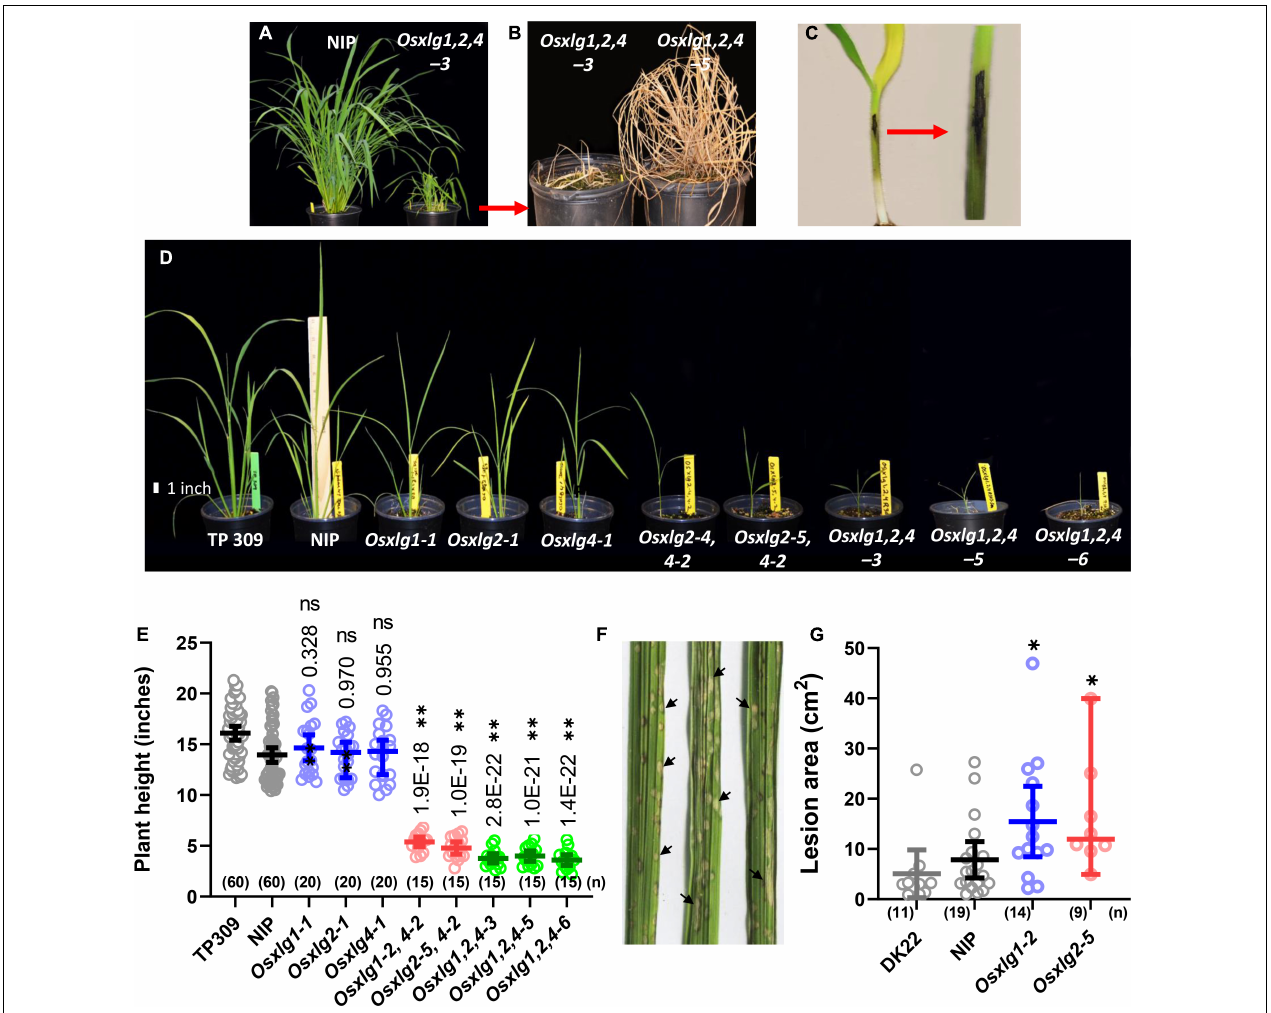
FIGURE 5 | Pathogen detection and growth phenotype of Osxlg mutant at seedling stage. Eighty-five-day-old NIP and triple mutant ( Osxlg1,2,4-3 ) plants (A) , the dead triple mutant plants ( Osxlg1,2,4-3, Osxlg1,2,4-5 ) (B) , pathogen infection at the seedling stage (C) , growth phenotypes of 5-week-old rice WT-NIP, Osxlg single, double, and triple mutant plants in 0.5-L pots (D) , the plant height of Osxlg mutants (E) lines in comparison with the controls (WT-NIP). Six pots of each genotype (NIP, Osxlg1-2 , Osxlg2-5 ) were used to measure lesion density caused by M. oryzae inoculation (isolate GY11). GY11 isolates provoke grayish lesions (F) at the center of which the fungus sporulates. Black arrows indicate grayish lesions. Lesion densities (G) were significantly higher in Osxlg mutants than in WT-NIP. DK22 genotype used as internal control. Asterisks indicate values significantly different from WT-NIP by ANOVA followed by Tukey’s multiple comparison test, ∗ p < 0.05, ∗∗ p < 0.001, ( n ) = sample size. ns, not